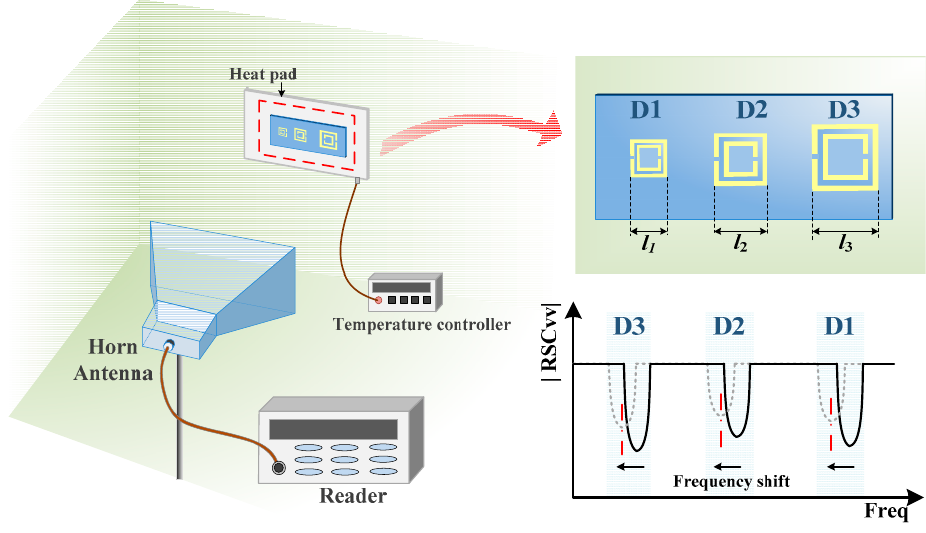
Figure 3. The schematic diagram of a chipless RFID system and tag coded with D1, D2, and D3.